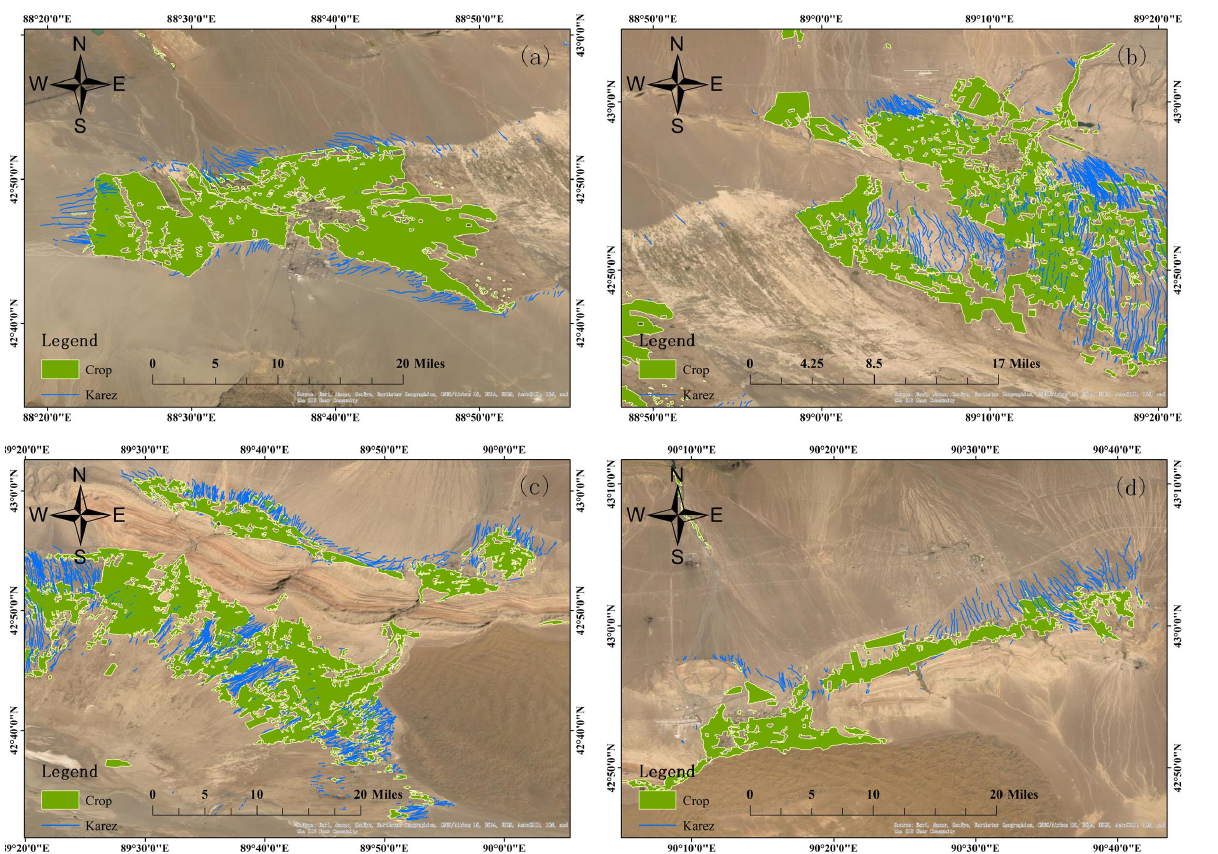
Figure 15. ( a – d ) are enlarged views of the four rectangular boxes from the left in Figure 14,